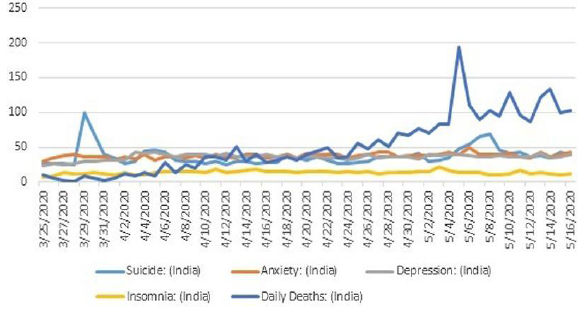
Fig. 1. Int Psychogeriatr. 2020 Jun 3: 1–2. Published